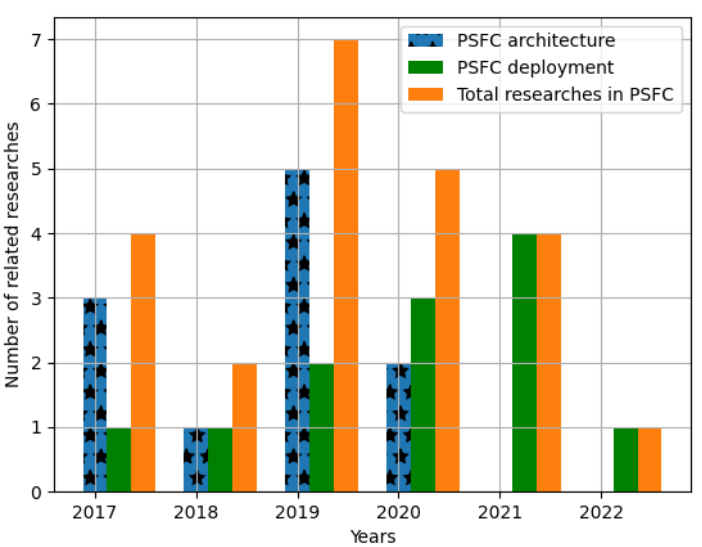
Figure 2. Statistics of studies on parallelized